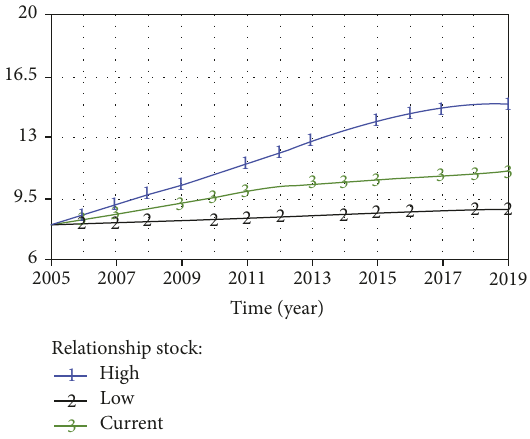
Figure 14: Influences of various trusts on relationship justice (RJ).